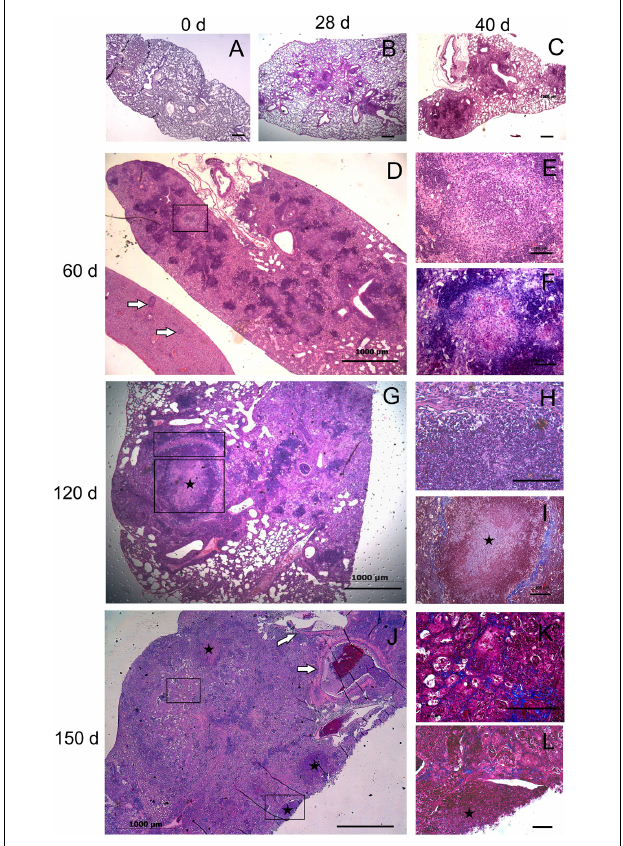
FIGURE 6 | Histopathological changes in the lungs of mice infected with highly virulent Mycobacterium kansasii strain 10953. C57BL/6 mice were infected, and lung pathology was examined during a 150-day period, on day 0 (A) , 28 (B) , 40 (C) , 60 (D–F) , 120 (G–I) and 150 (J–L) . Representative lung sections stained by H&E (A–E,G,H,J) , Ziehl-Neelsen (F) or Masson’s Trichrome methods (I,K,L) are shown. Small granulomas seen on day 28 (B) , increased by day 40 (C) , and progressed to extensive granulomatous pneumonia by day 60 (D) . Area of initial intragranulomatose necrosis, marked by black square in panel (D) , is enlarged in panels (E,F) , demonstrating large numbers of dying cells (E) and AFB (F) . In panel (D) , a liver section (l) eventually is localized by side of the lung section; white arrows indicate several granulomas in the liver. By day 120, necrotic lesions progressed to large caseous granulomas marked by black squares (G) . The upper and the lower squares refer to areas of higher magnification in panel (H) (peripheral area composed by neutrophil-predominant cell infiltrates) and (I) (central area occupied by acellular caseum), respectively. Note a fibrotic capsule surrounding the necrotic lesion (I) . By day 150 (J) , necrosis leads to destruction of normal lung structure (symbol *) with easy dislocation of the amorphous necrotic material [lower black square enlarged in panel (L) ] and its presence in occluded bronchial airways [black arrows in panel (J) ]. The area marked by upper square in panel (J) , enlarged in panel (K) , demonstrates significant interstitial fibrosis of the lung. Bars, 1,000 µ m (A–D,G,J) , 100 µ m (E,F,H,I,K)